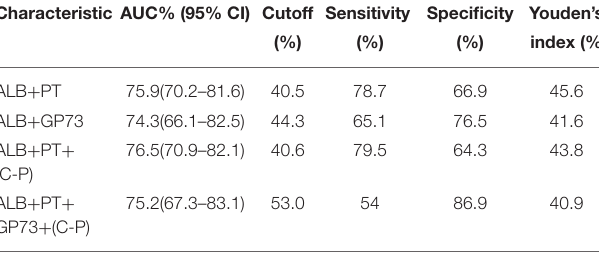
TABLE 4 | Diagnostic accuracy of parallel combination of variables in the prediction of esophageal variceal